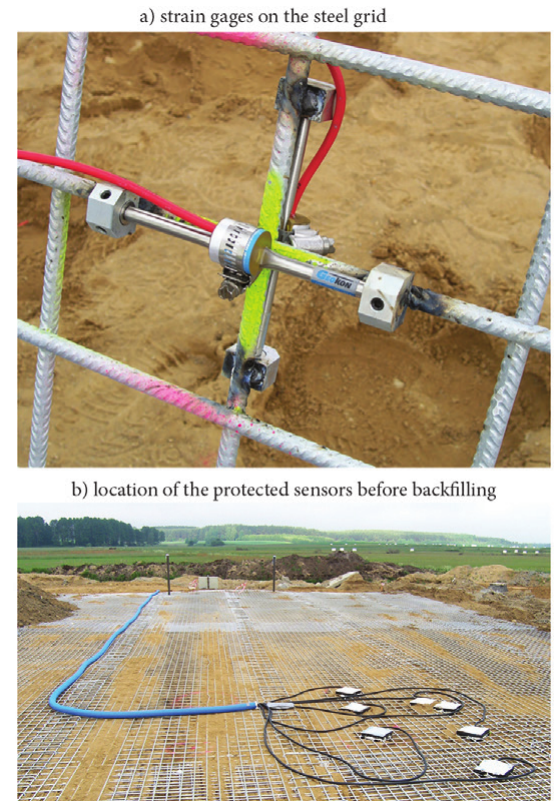
Fig. 6. Measured points on steel grid